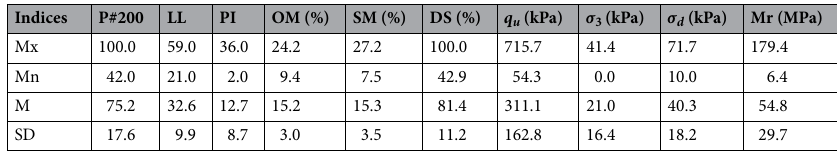
Table 1. Statistical characteristics of main engineering properties of soil datasets.